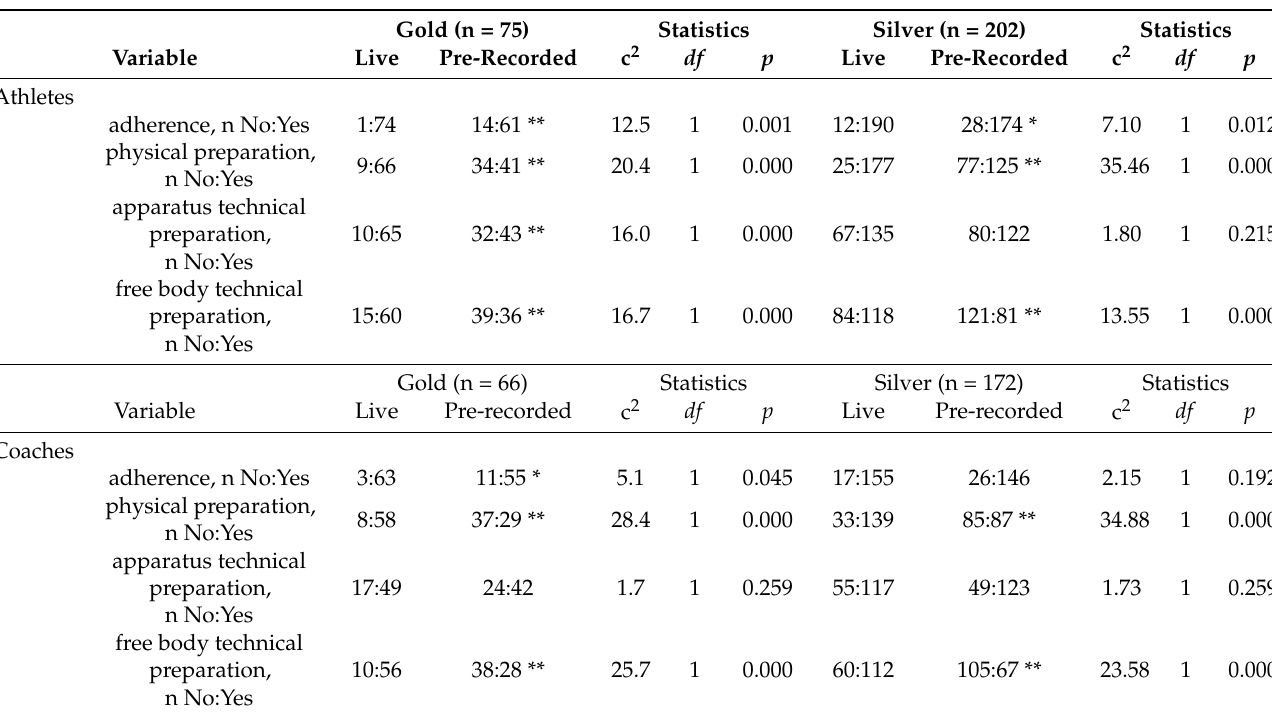
Table 2. Athletes’ and coaches’ answers on training adherence and type of training performed (physical preparation, apparatus technical preparation, and free body technical